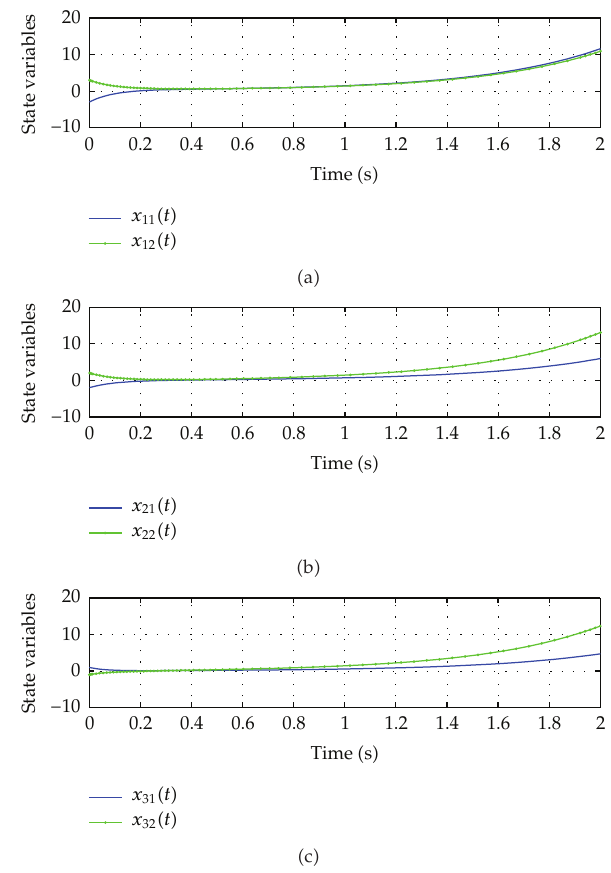
Figure 1: The state response with u i (cid:2) t (cid:3) (cid:8)